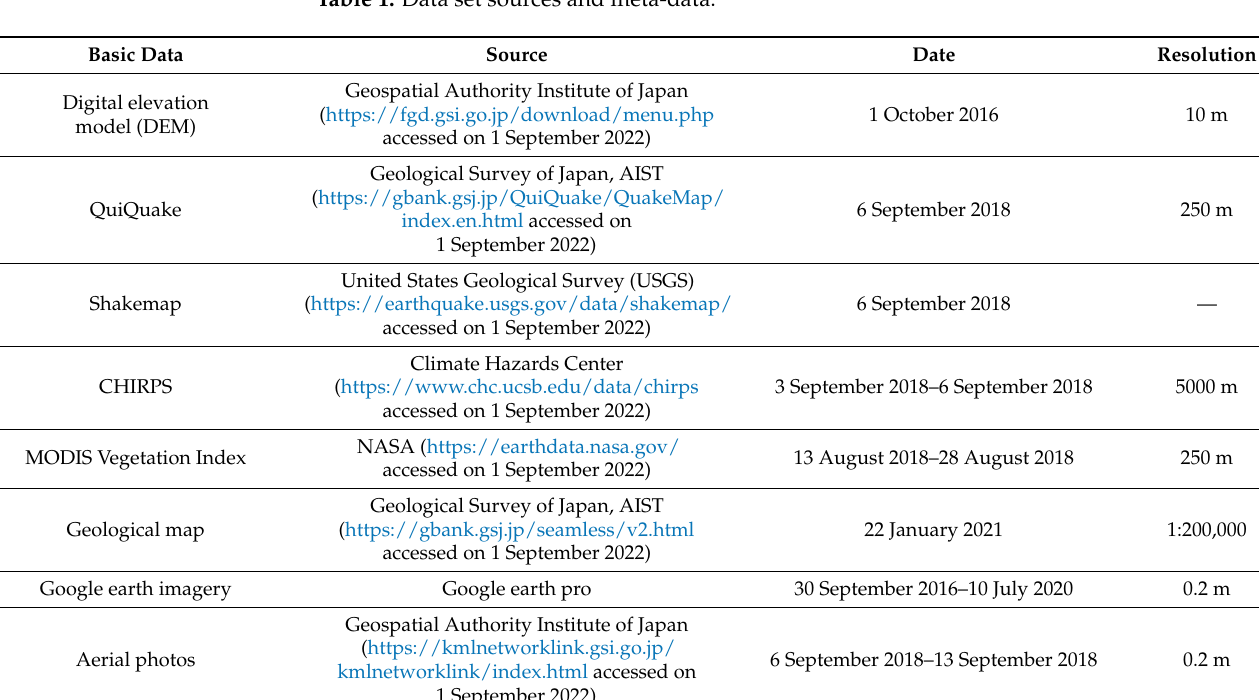
Figure 1. The scheme of the present study. Table 1. Data set sources and